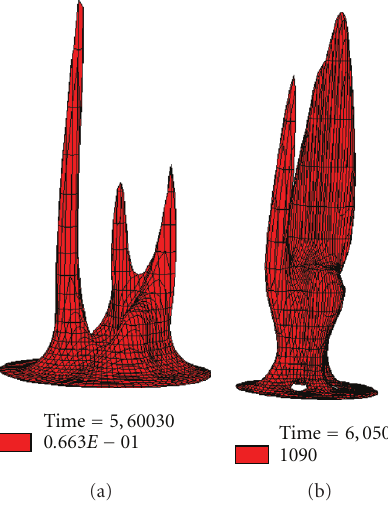
Figure 2: Example simulation of the time history of a gasoline fire caused by a gas station accident. (a) the isosurface of relative mass fractions of gasoline, corresponding to the highest-rate reaction in the air-and-fuel mixture combusting under a wind load (stoichio- metric mass fraction); (b) is the isosurface of the temperature field. (measurement 2) − 807 K, and at a height of 1.92 m − 818